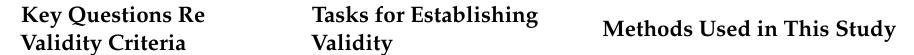
Table 3. Framework for validity in realist research in sports and exercise